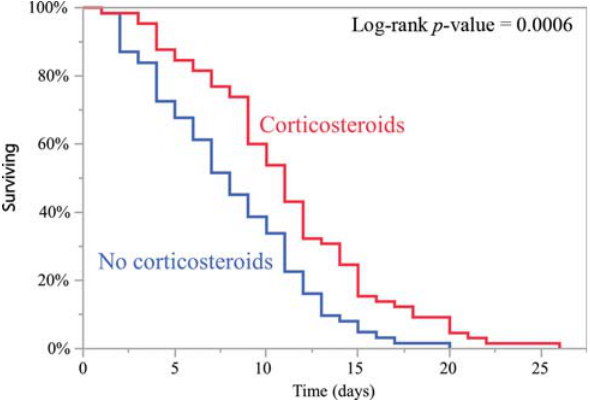
Fig. 3 Kaplan – Meier analysis of time to death in patients who received immunosuppressive doses of corticosteroids and those who did